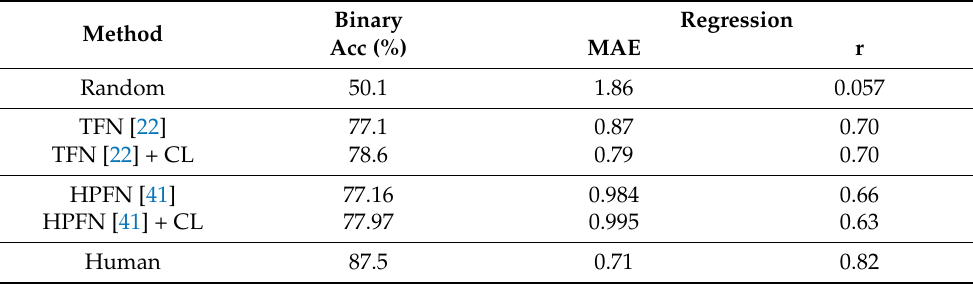
Table 1. CMU Multimodal Opinion-Level Sentiment Intensity (CMU-MOSI) experiment results. All the results are reproduced, except for TFN we are using the performance from the original paper. MAE: Mean Absolute Error.